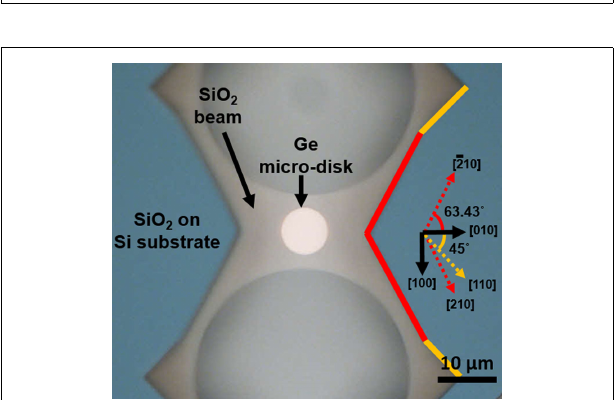
FIGURE 1 | Three-dimensional sketch showing a Ge micro-disk on a suspended SiO 2 beam with curved edges and supported by SiO 2 on Si substrate . Fabrication design parameters, beam width ( w ), and beam length ( l ) are shown from a top-view in the top right corner. Axes orientation apply for the 3D sketch only.